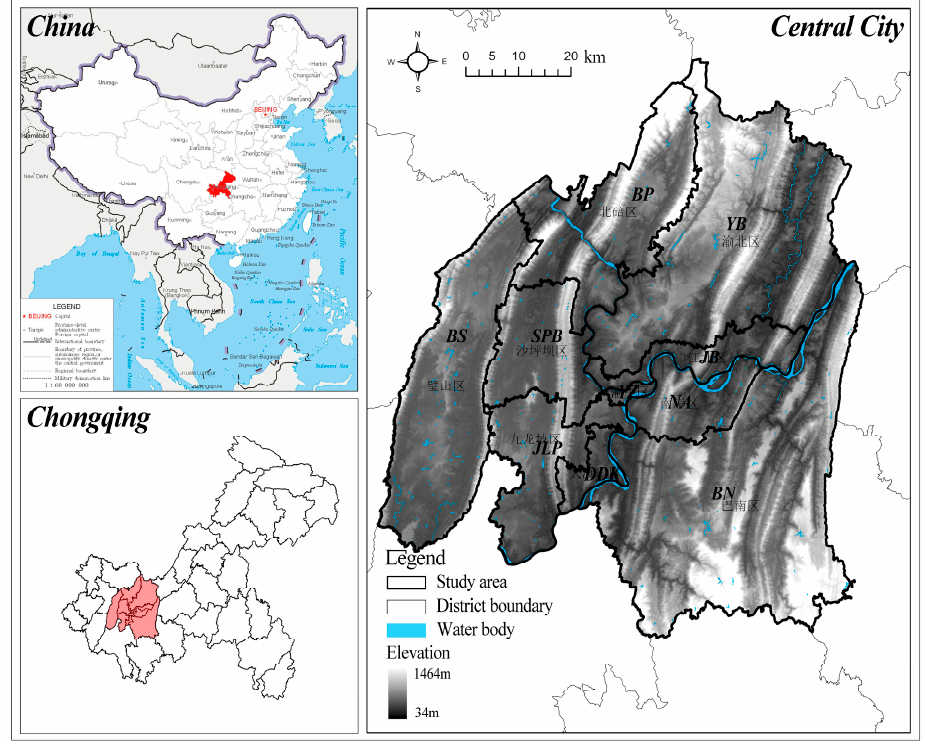
Figure 1. Study Figure 1. Study area.